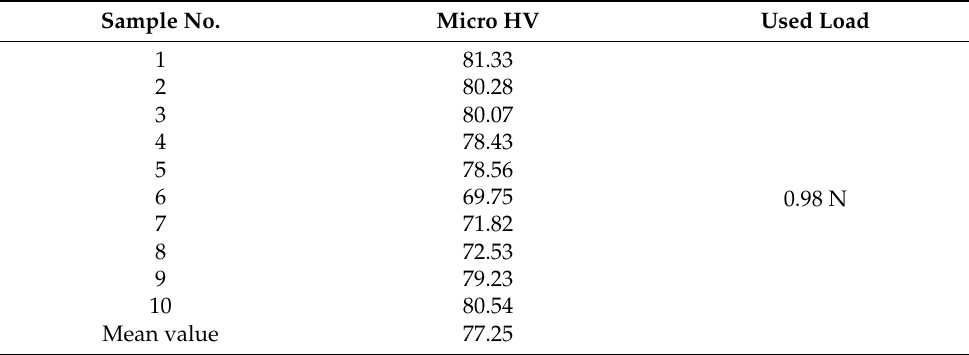
Table 2. Measured values of micro-hardness of polished sample of galena lump. Sample No.